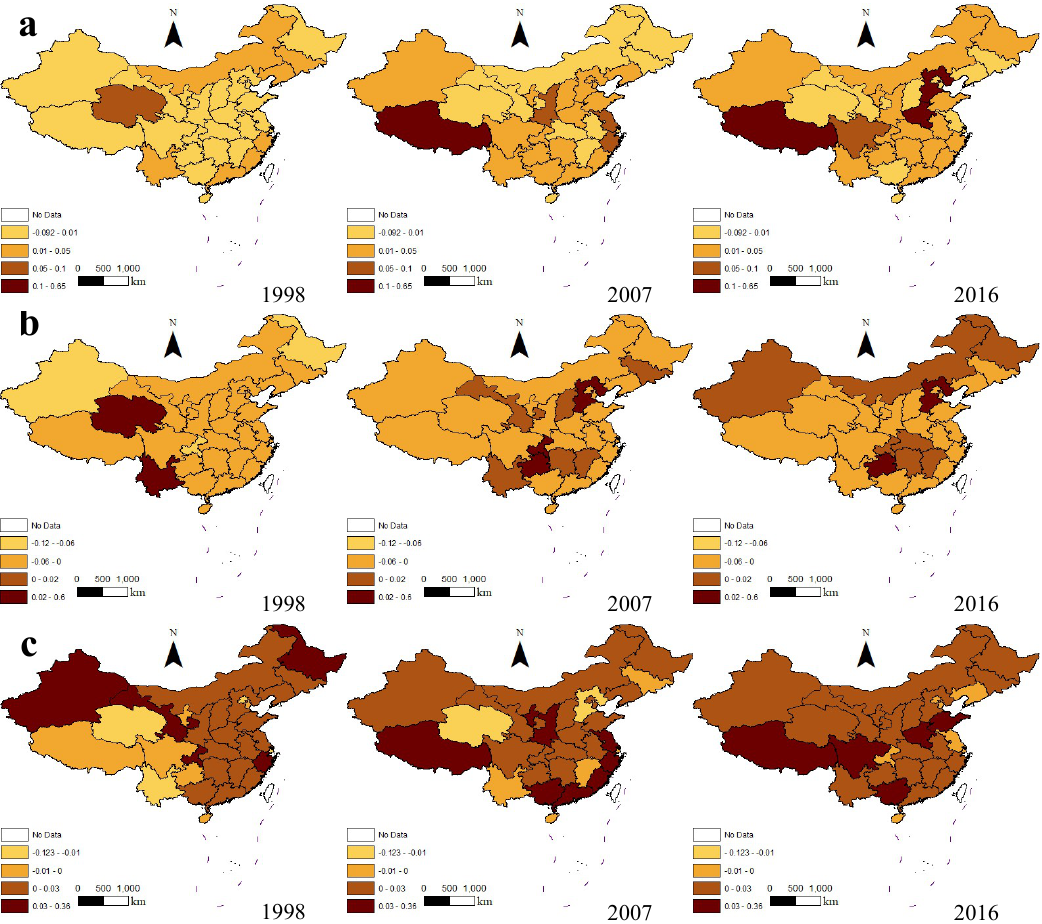
Figure 3. The difference values between the GTFPI and TFPI, GTEC and TEC, and GTPC and TPC in 1998, 2007 and 2016 were distributed in provinces across the country. ( a ) The gap between the GTFPI and TFPI; ( b ) the gap between the GTEC and TEC; ( c ) the gap between the GTPC and TPC.